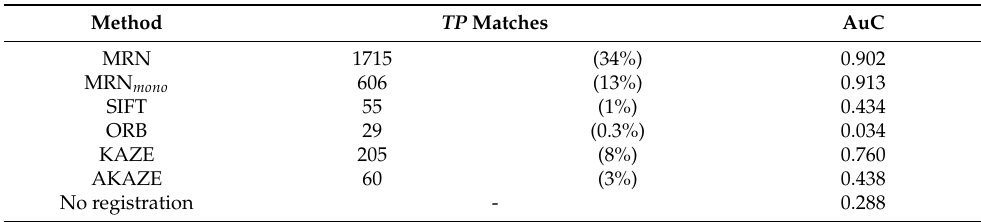
Table 2. Registration results. MRN is MedRegNet. TP matches are the average number of correctly matched interest points, i.e., point pairs that after registration have an euclidean distance < 5 px. The number in brackets shows the percentage of all matched points, which are TP. AuC is the Area under Curve for the plots shown in Figure